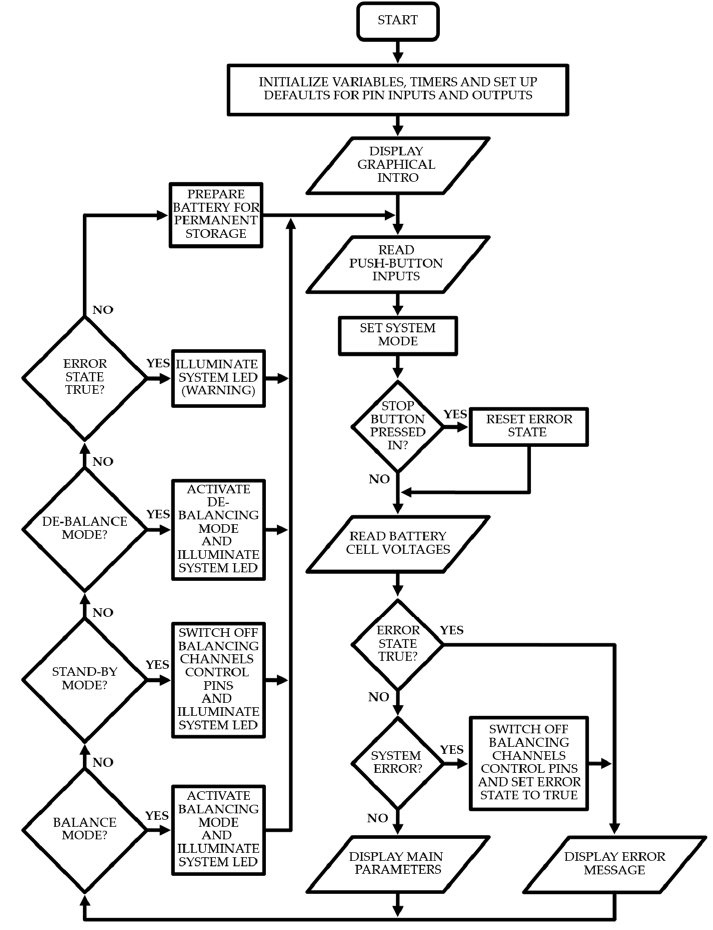
Figure 9. Main system code flowchart.